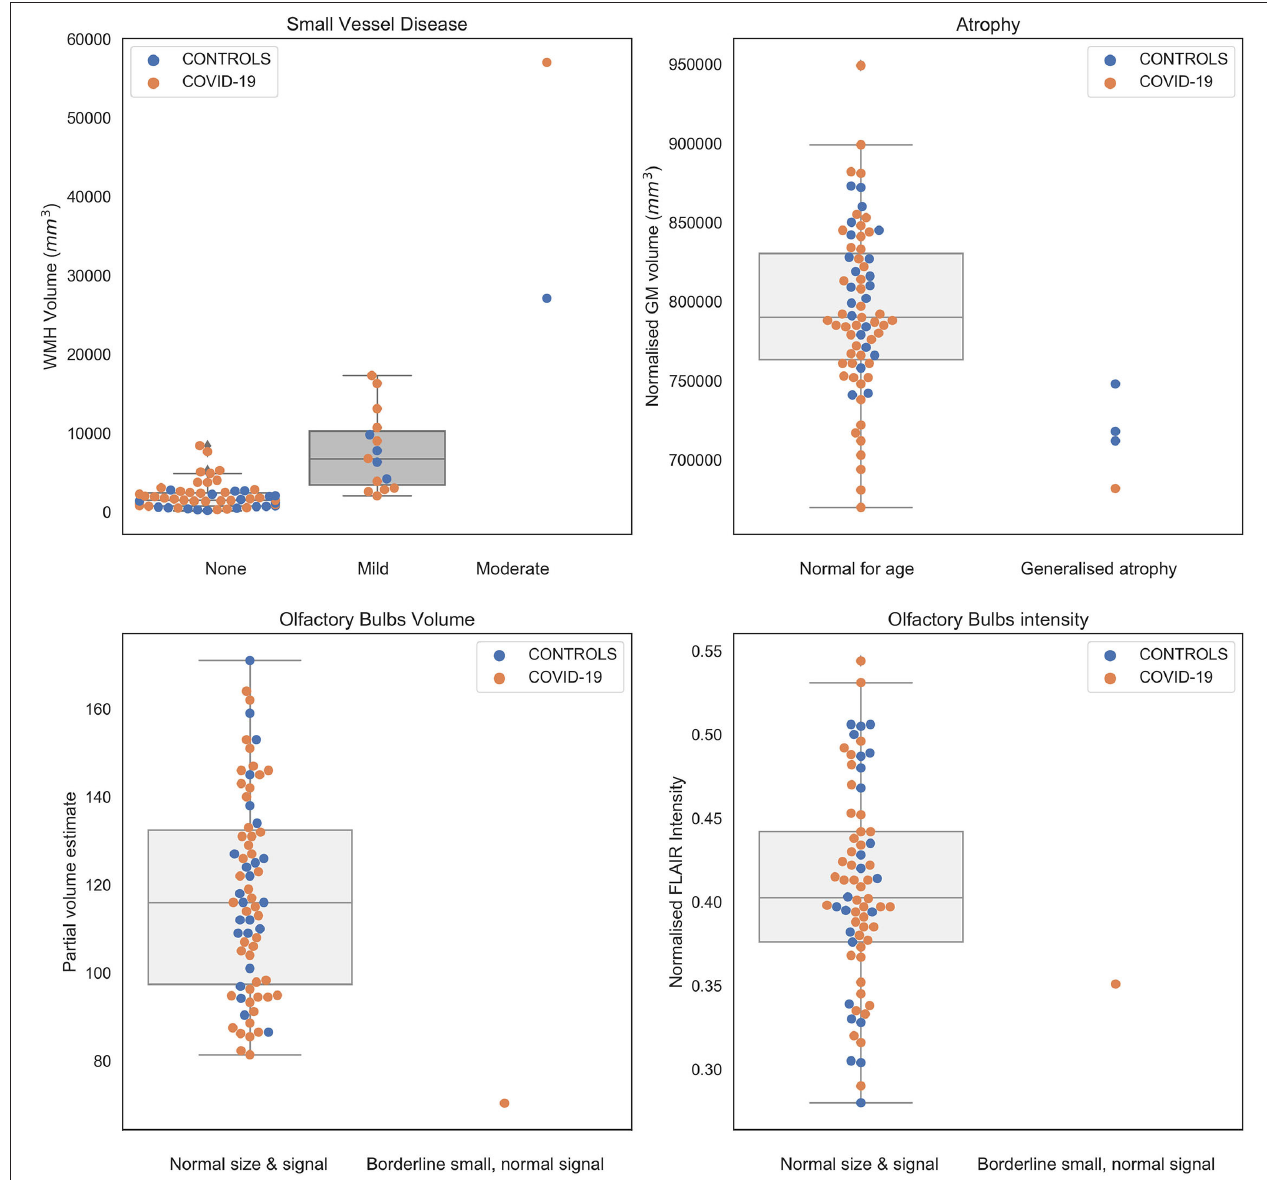
FIGURE 2 | Values of IDPs derived from patients (orange) and controls (blue) from the automated pipeline against the classification obtained from clinical radiology reports (blind to diagnosis and results of the pipeline). Numerical values are reported in Supplementary Table 2 .